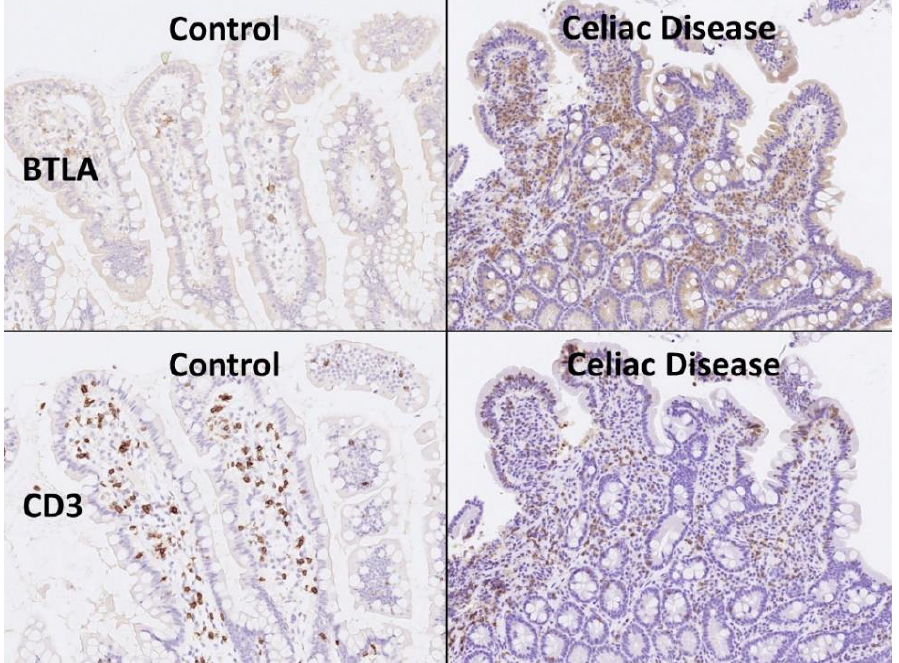
Figure 6. BTLA protein expression by immunohistochemistry. Celiac disease cases were characterized by chronic inflammation of the lamina propria that was BTLA-positive. Using CD3 the T-cell lymphocytes are highlighted, including the higher presence of intraepitheal lymphocytes (IELs that characterize celiac disease). BTLA, B and T lymphocyte attenuator, is an inhibitory receptor with similarities to CTLA and PD-1. BTLA-deficient mice have increased specific antibody responses and enhanced sensitivity to experimental autoimmune encephalomyelitis (Uniprot).